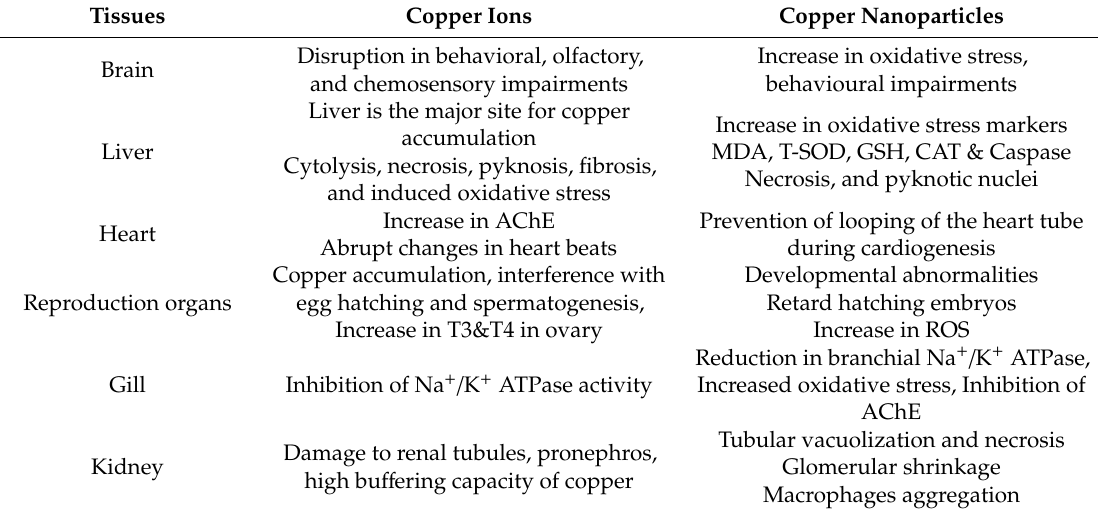
Table 3. The significant outcomes of the toxicity of copper and copper nanoparticles to fish based on di ff erent tissue types. Tissues Copper Ions Copper